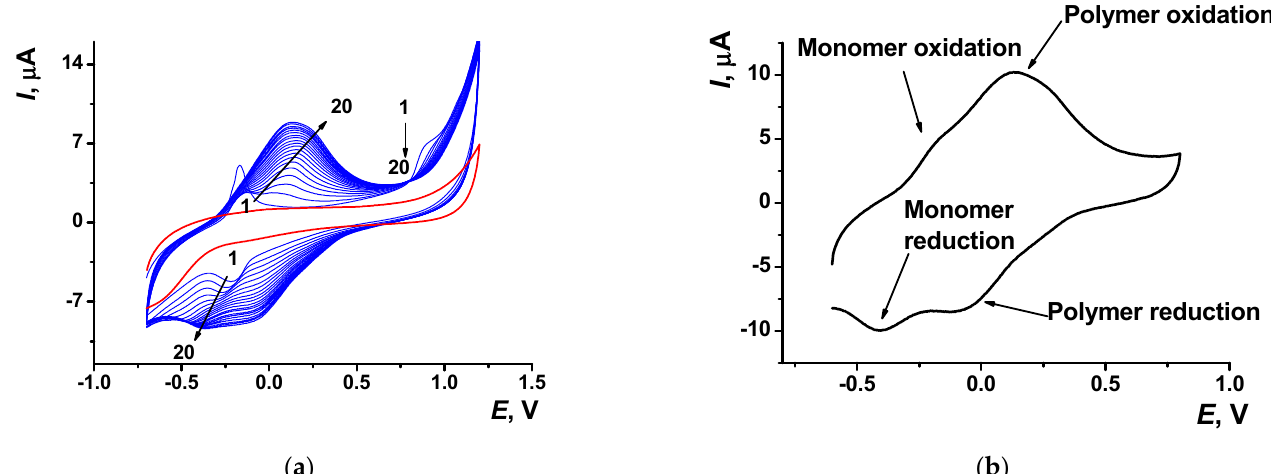
Figure 2. ( a ) Multiple cyclic voltammograms recorded on the GCE in 0.1 M phosphate buffer containing 0.1 M NaNO 3 and 0.2 mM Azure A, pH = 7.0; scan rate 100 mV/s. Red line corresponds to the bare GCE. Arrows indicate changes in the peaks from the 1st to 20th cycle. ( b ) Single cycle recorded on the GCE covered with poly(Azure A) transferred in the same buffer with no monomer dye.